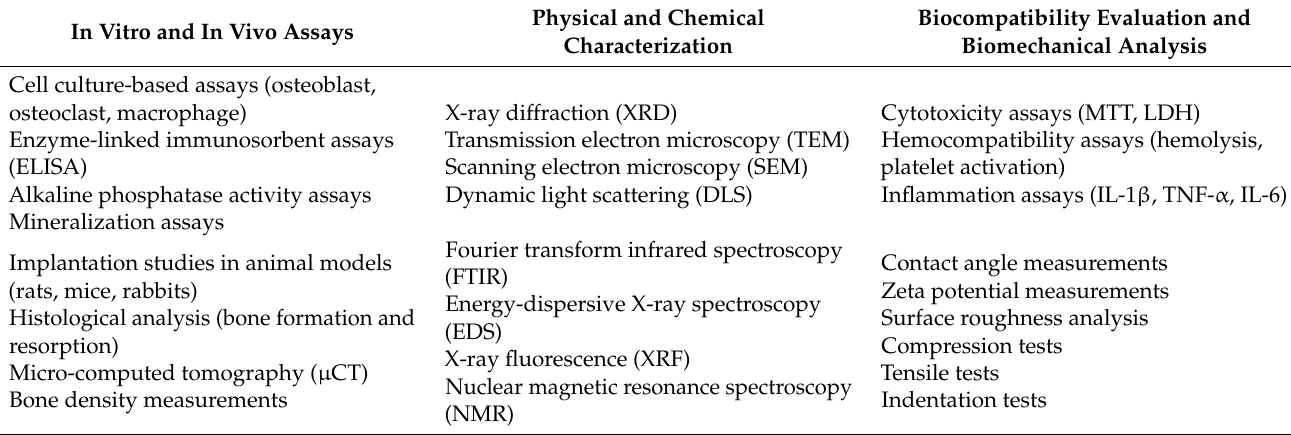
Table 1. Experimental Approach for Osteoimmunomodulation